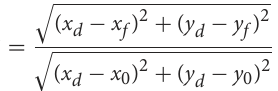
the controller, the reliability is set as another index for the controller’s